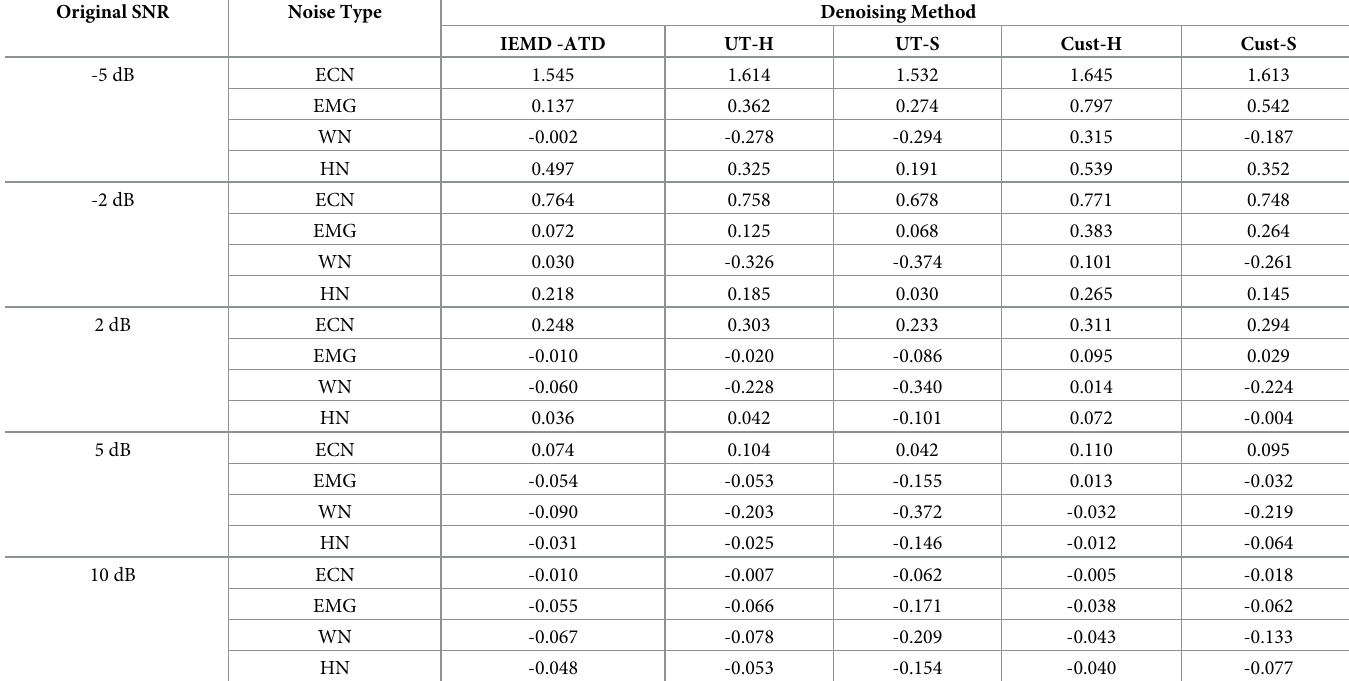
Table 15. Average relative differences in signal energy of 10 real